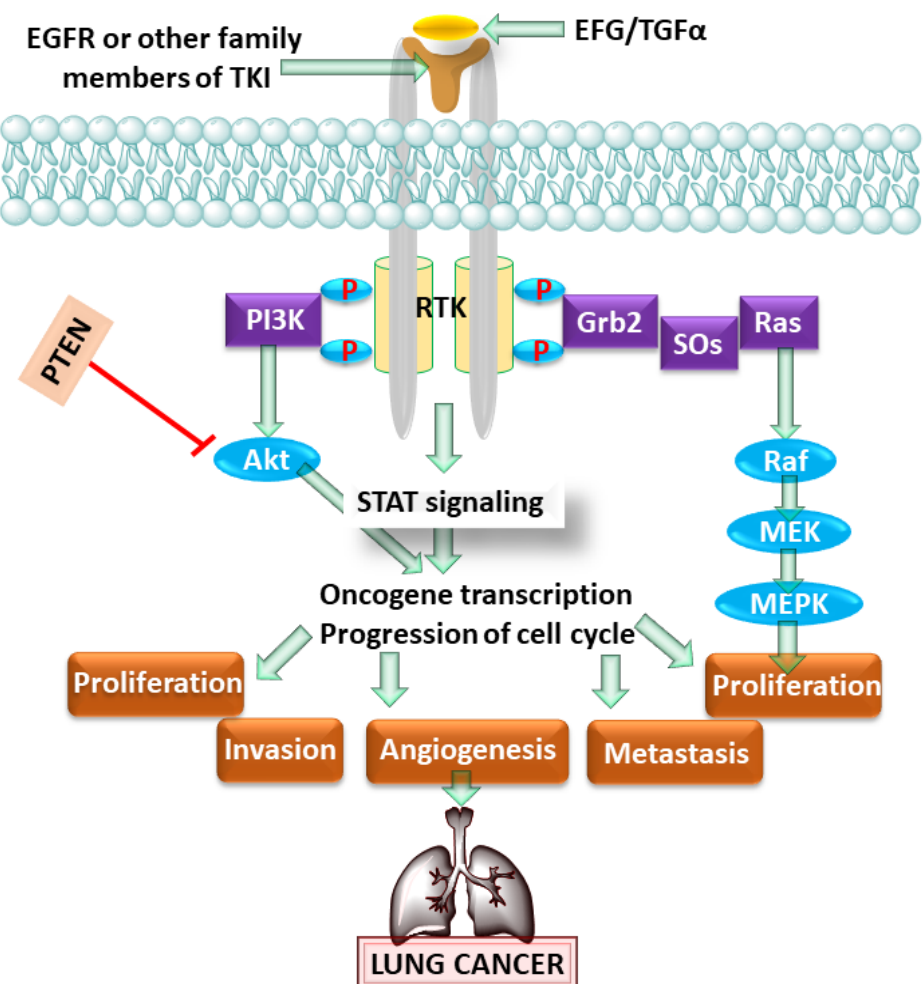
Figure 1. Showing the role of the epidermal growth factor receptor (EGFR) pathway in lung cancer. epidermal growth factor (EGF), transforming growth factor (TGF α ), Growth factor receptor-bound protein 2 (Grb2), son of sevenless (SOs), Mitogen-activated protein kinase (MAPK) and signal transducer and activator of transcription (STAT).